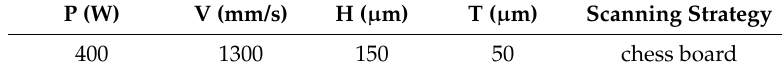
Table 2. Parameters of the SLM process (P—power, v—scanning velocity, h—hatching distance, t—layer thickness).